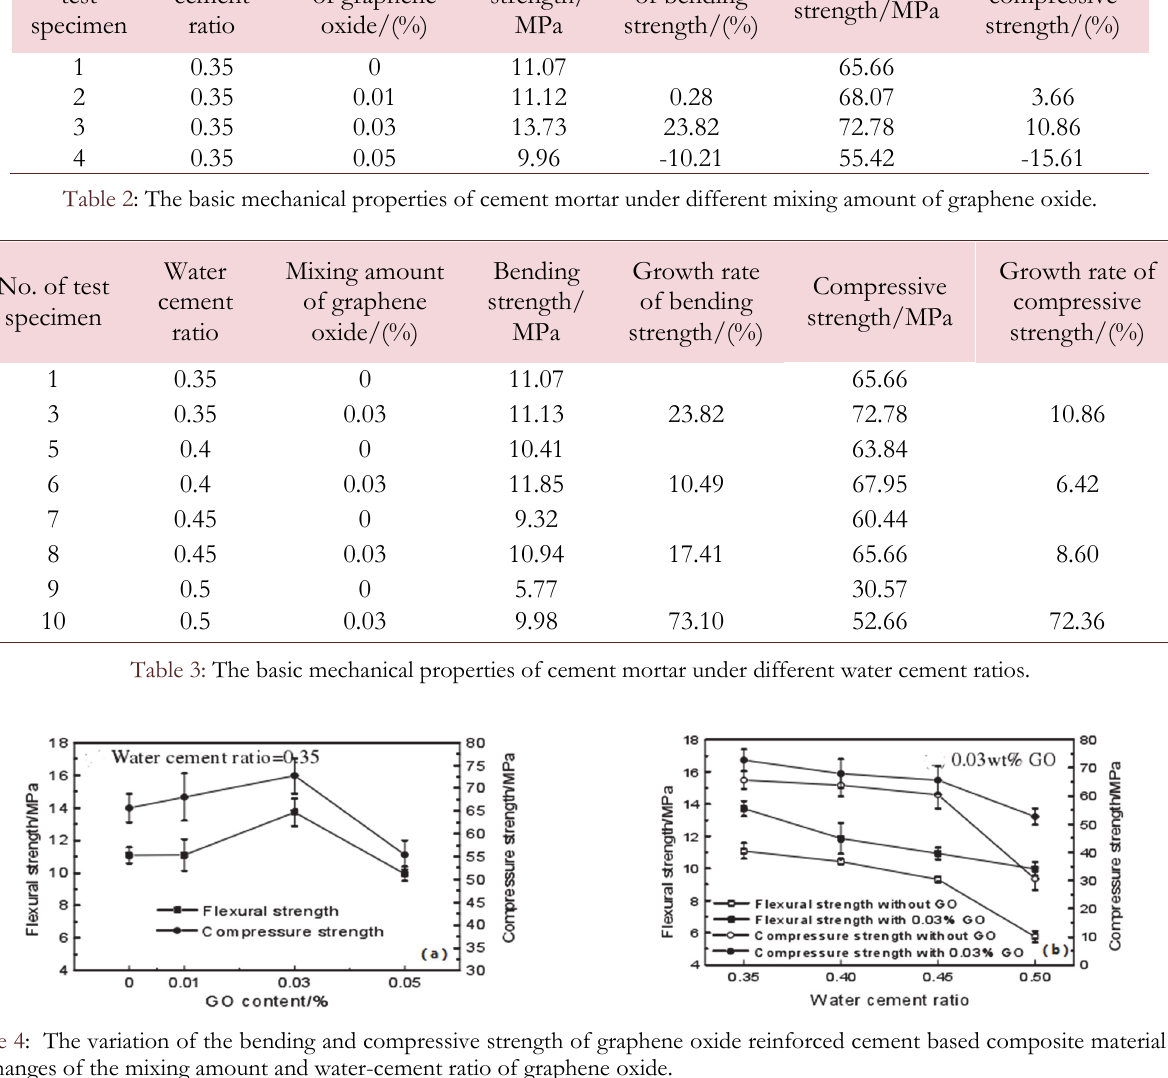
Figure 4: The variation of the bending and compressive strength of graphene oxide reinforced cement based composite material with the changes of the mixing amount and water-cement ratio of graphene